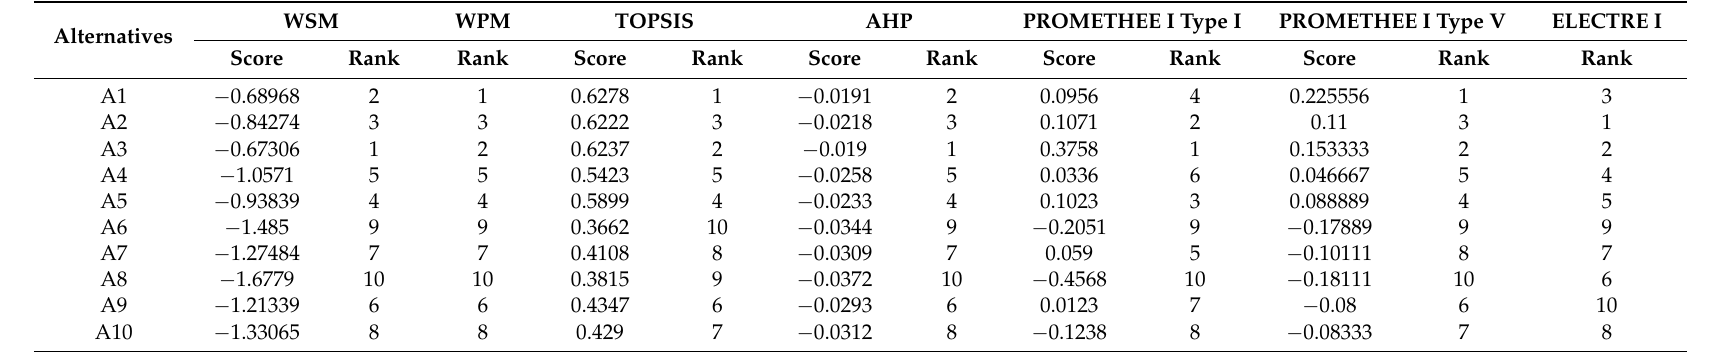
Table 5. WSM, TOPSIS, AHP, PROMETHEE I and ELECTRE I results and